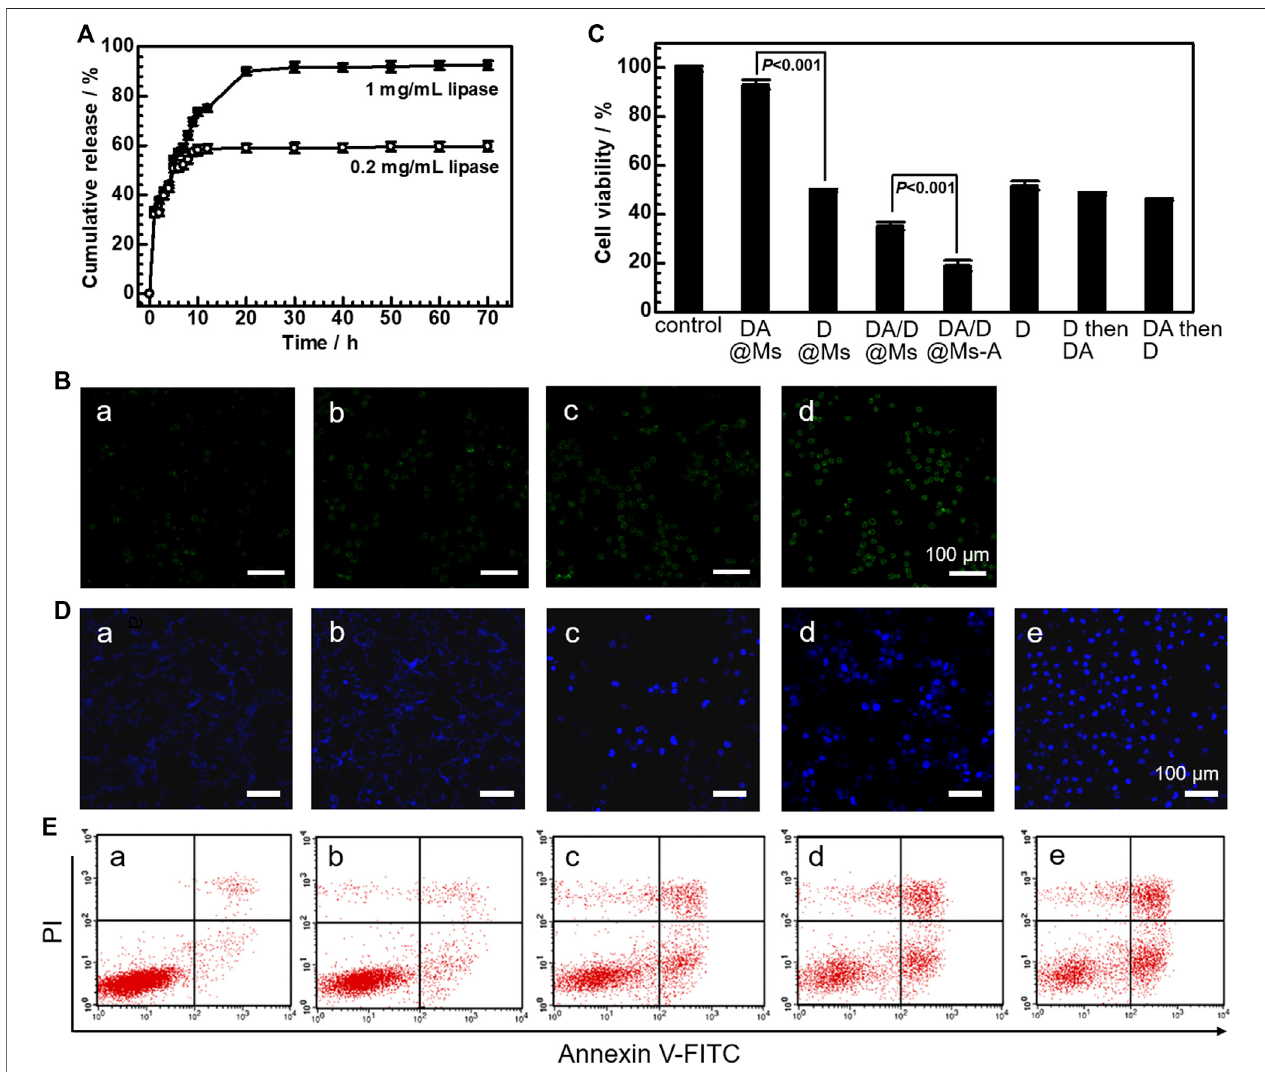
FIGURE 5 | In vitro cytotoxicity. (A) The release pro fi les of Dox from D@Ms in the presence of 0.2 mg/ml and 1 mg/ml lipase. (B) Fluorescence imaging of H 2 S release in Panc-1 living cells after incubation with (a,b) DA@Ms and (c,d) DA@Ms-A for 2 h (a,c) and 4 h (b,d) , respectively. (C) Cell viability of Panc-1 cells treated with 0.1 mg/ml micelles and Dox for72 h, 0.05 mg/ml Dox for36 hthen 0.05 mg/ml DATS for36 h, and 0.05 mg/mlDATS for 36 h then 0.05 mg/ml Dox for36 hby CCK-8 assay, respectively. (D) CLSM images of Panc-1 cells stained with Hoechst 33258 and (E) fl ow cytometry of Panc-1 cells stained with FTIC and PI after treatment with 0.1 mg/ml micelles for 24 h. (a) control, (b) DA@Ms, (c) D@Ms, (d) DA/D@Ms, and (e) DA/D@Ms-A.